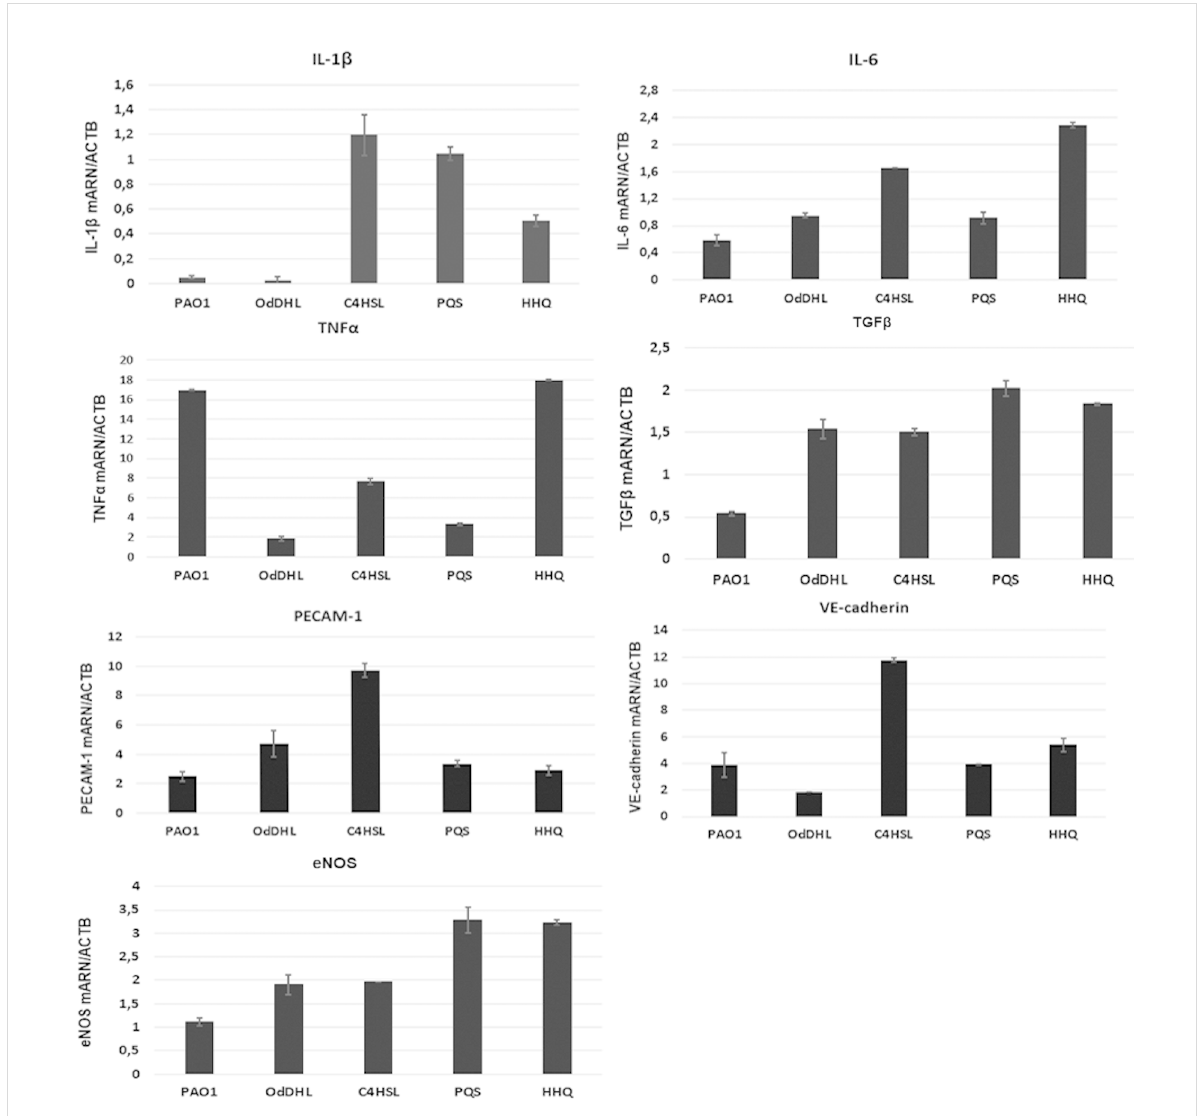
Figure 5: Expression levels (fold change) in qRT-PCR experiments for IL-1 β , IL-6, TNF α , TGF β , eNOS, VE-cadherin and PECAM-1 molecules per- formed on endothelial cells treated with PAO1 cultures and purified QSSMs ( P < 0.05, based on ANOVA and Bonferroni post test of medians of 4 in- dependent experiments performed in triplicate ( n =